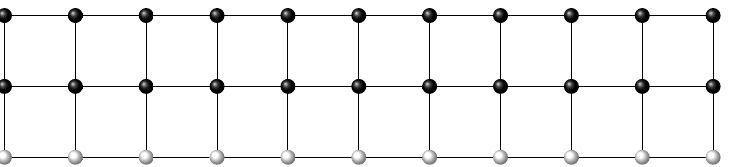
Figure 4. A minimum doubly connected dominating set of G [ 11,3 ] formed by the set of all black nodes.